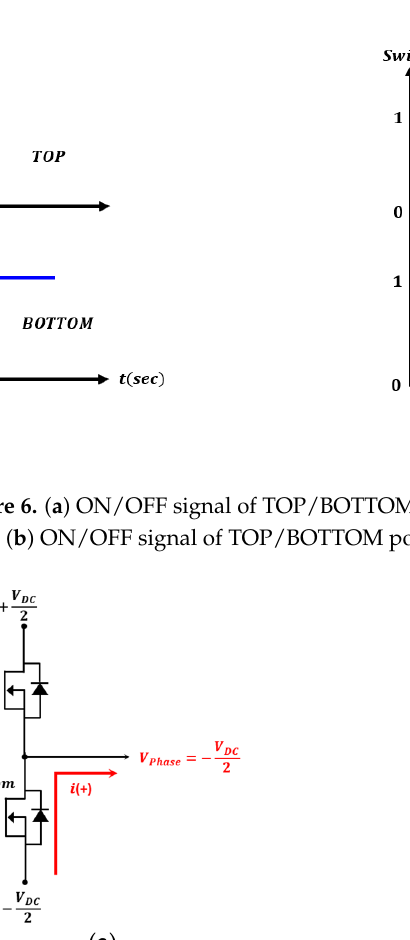
Figure 5. ( a ) VSI (voltage source inverter) configuration block diagram. ( b ) VSI each phase power switch configuration diagram.